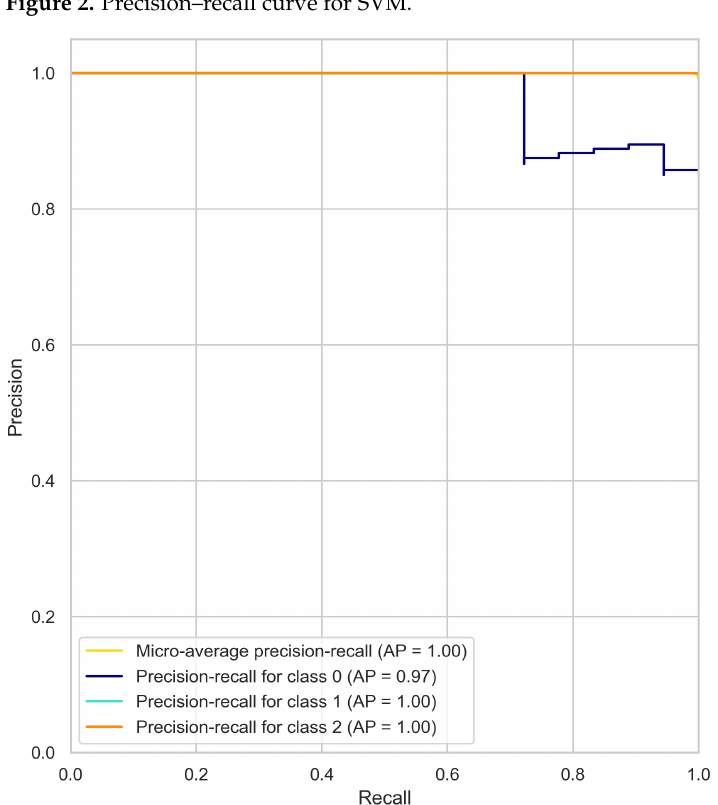
Figure 3. Precision–recall curve for random